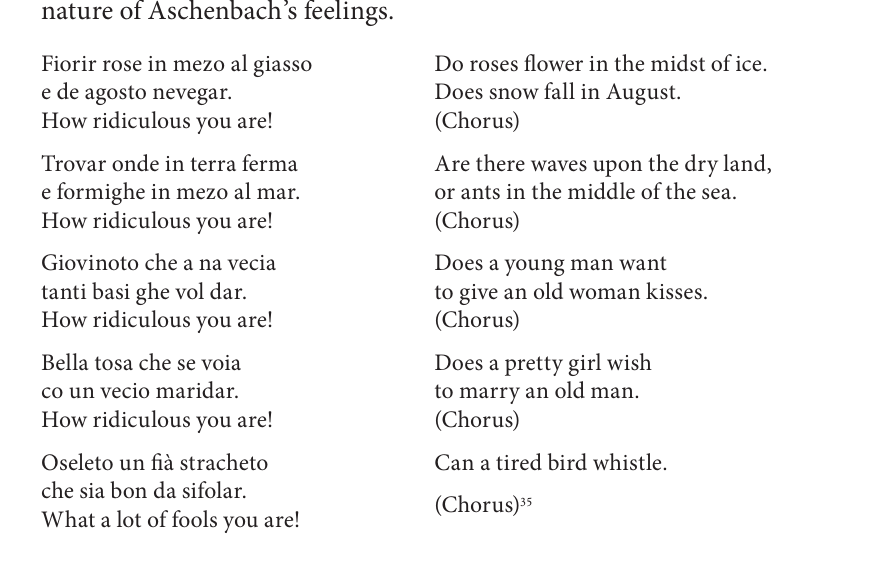
Fig. 2 Death in Venice , Piper’s “Laughing Song,” lyrics